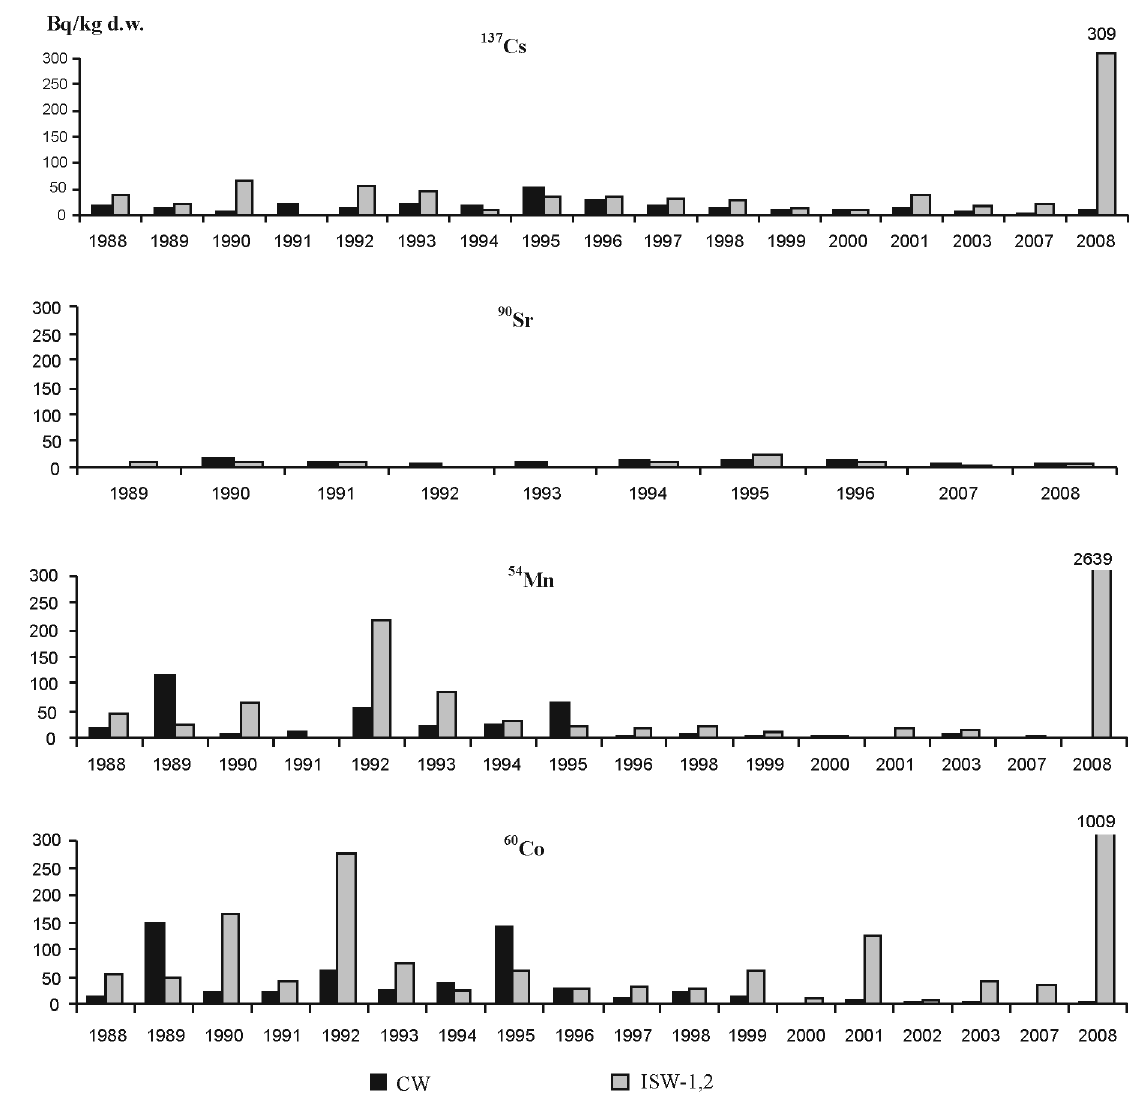
Fig. 5. Activity concentration of radionuclides in macrophytes of wastewater discharge channels of the Ignalina